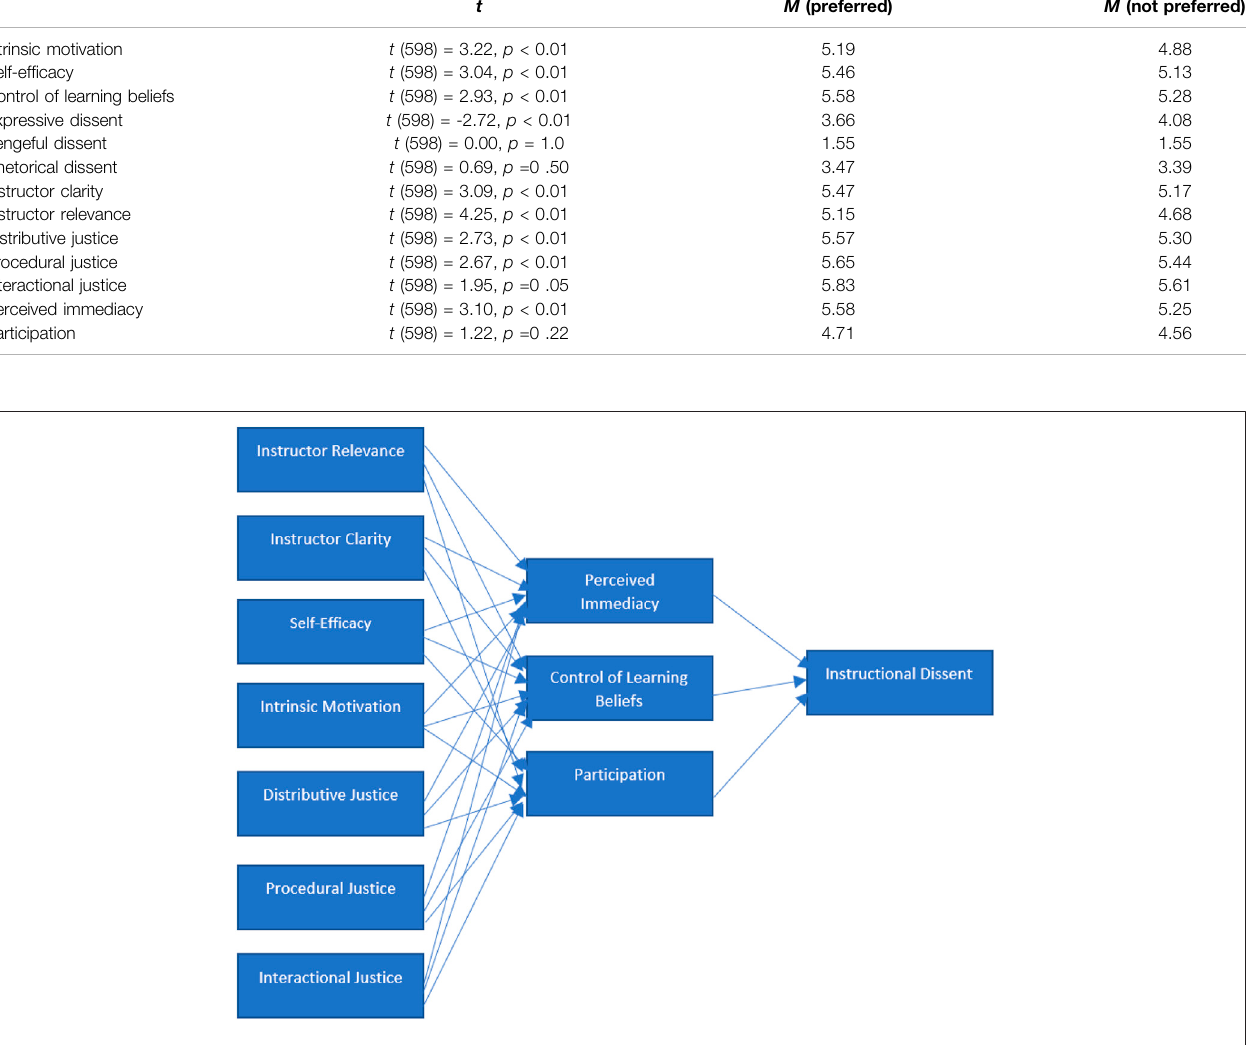
FIGURE 1 | Proposed